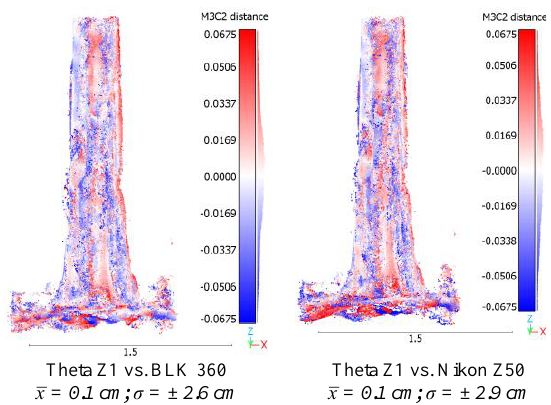
Figure 5 . M3C2 analysis of the Theta Z1 point cloud, compared to TLS and close-range